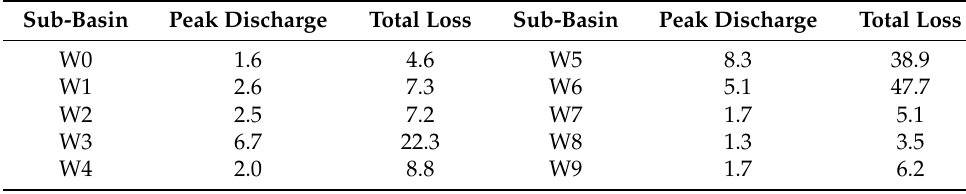
Figure 5. The sub-basins of the Koupa basin. Table 2. Peak and total loss per sub-basin in m 3